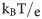
Primary site phosphorylation increases R1 cross-talk.A. Changes in the electrostatic environment (red = negative (acidic), blue = positive (basic), white = neutral (non-polar) triggered by T286 modification (-> TPO phosphorylation or -> D mutation). The binding crevice becomes more negative while the adjacent subunit interface becomes more positive. Color scale is -3 to + 3 kT/e mV. B. Phosphorylation dependent residue pK shifts (mean ± standard error) of polar residues (n = 73). Colors denote residues shifted towards negative (red), positive (blue) or more neutral (dark grey) values. C. Polar residue (stick side-chains; colors as in B (n = 146)) pK shifts > 0.5 mapped onto the C-lobes of the 3KK8D.pdb dimer. The computed net pK change upon phosphorylation is +1.95 ΔpK / dimer (0.0135 ± 0.005 ΔpK (0.8 ± 0.3 kBTe mV) / residue).